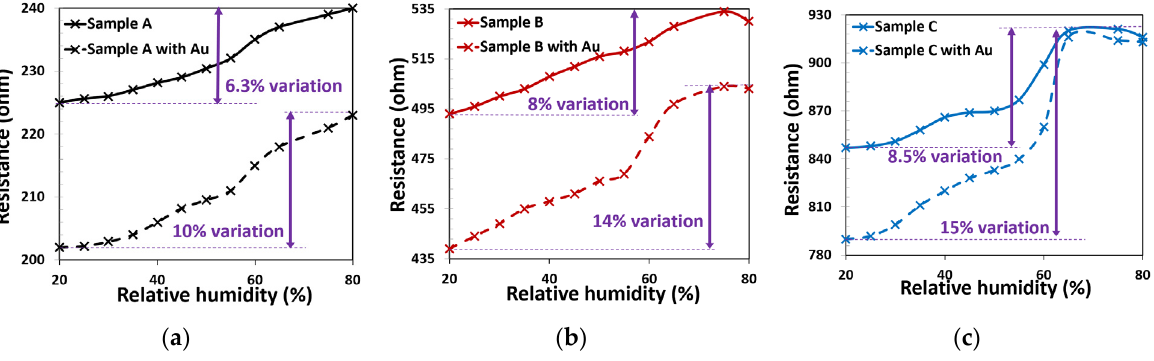
Figure 8. Variation in actual resistance of fabricated samples in terms of relative humidity at room temperature and atmospheric pressure. ( a ) Sample A and sample A decorated with Au NPs. ( b ) Sample B and sample B decorated with Au NPs. ( c ) Sample C and sample C decorated with Au NPs. CNF decorated with Au Np sensors behave similarly to CNF sensors in a variation of humidity. Likewise, increasing the humidity in these sensors reduces the